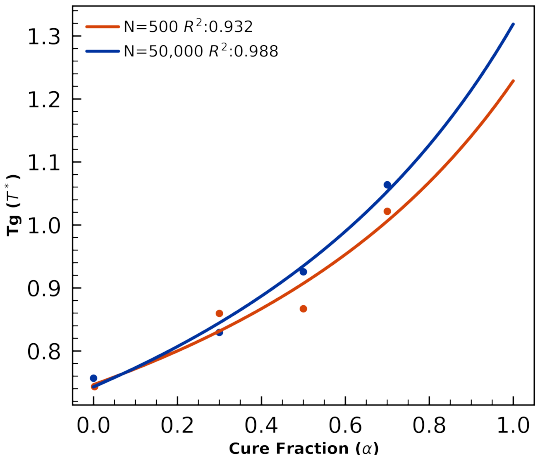
Figure 3. T g ( α ) calculations and DiBenedetto fits for N = 500 (orange) and N = 50,000 volumes of coarse-grained 44DDS/DGEBA/PES show the smaller system sizes result in noiser T g